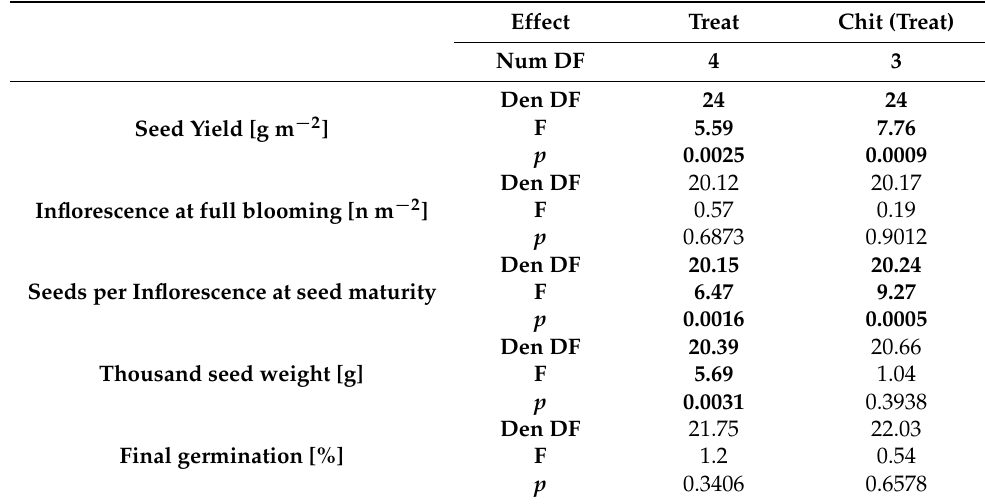
Table 2. F and p -values of the general linear mixed model applied to the onion grain yield, yield components and final germination. Factors were the moment and amount of ethylene applied [Treat] and the Chitosan nested in the ethylene application [Chit(Treat)]. Moment of ethylene application included an early, mid, and late applications indicated as first, second and third (1st, 2nd, and 3rd, respectively) occasions in the figures. Amount of ethylene application included 100% recommended rate (in the 1st or 3rd occasions) or 100% in the 1st + 50% in either the 2nd or 3rd occasions. Chitosan application was performed in "Treat” including a 100% application in the 1st occasion (irrespective of the further 50% application in the 2nd or 3rd occasions) compared to a non-chitosan treatment. A control with no chitosan and no ethylene was included. Values at p < 0.05 were indicated in bold. Numerator degrees of freedom are indicated once and apply to all variables, denominator degrees of freedom were estimated by the Kenward Roger approximation. LS means and their standard error estimation are provided in Supplementary Material Table